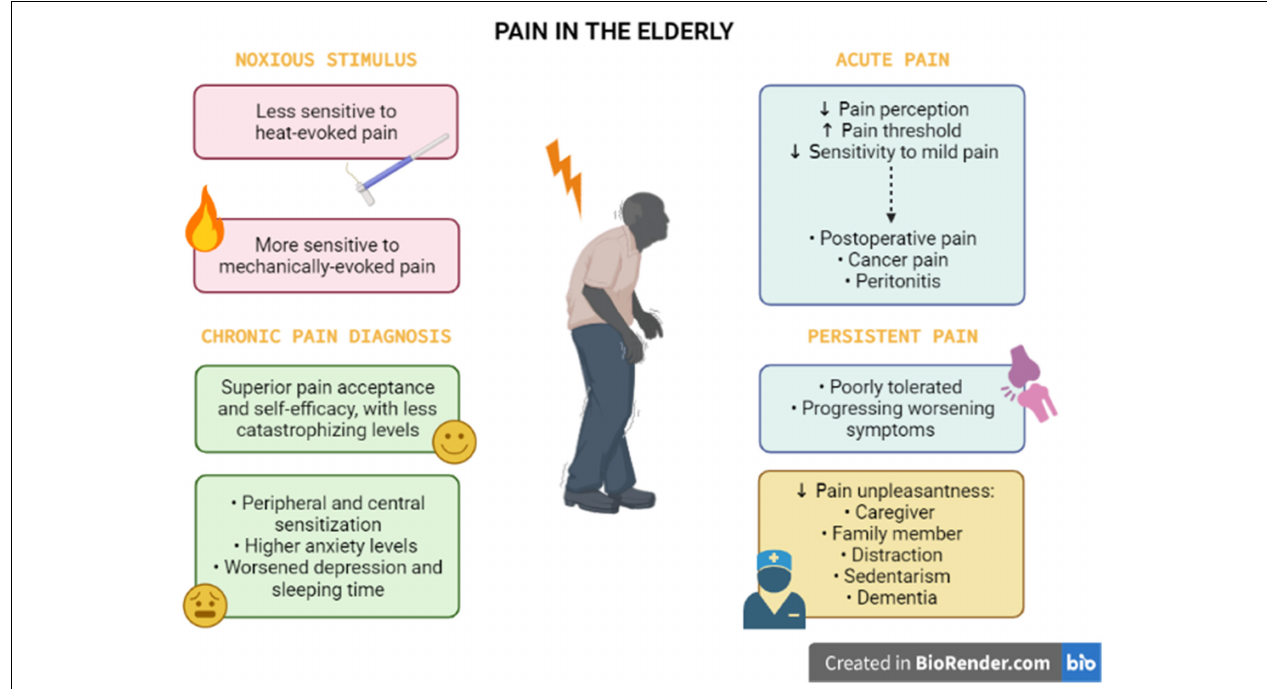
FIGURE 1 | Pain perception and experience in the elderly. The pain perception in the elderly is complex, with biopsychosocial factors associated. The older individuals present opposite sensitivity for heat and mechanically evoked pain. This population apparently tolerates acute pain (postoperative and cancer pain, peritonitis), when compared with persistent pain states. For chronic pain diagnosis in the elderly, health professionals should consider that older adults demonstrate particularities such as superior pain acceptance and self-efficacy, with less catastrophizing levels. However, the elderly has altered peripheral and central sensitization combined with higher levels of anxiety, depression, and insomnia. Social support from a family member or a caregiver, distraction, sedentary life, and dementia can influence the pain experience of older people, leading to changes in pain